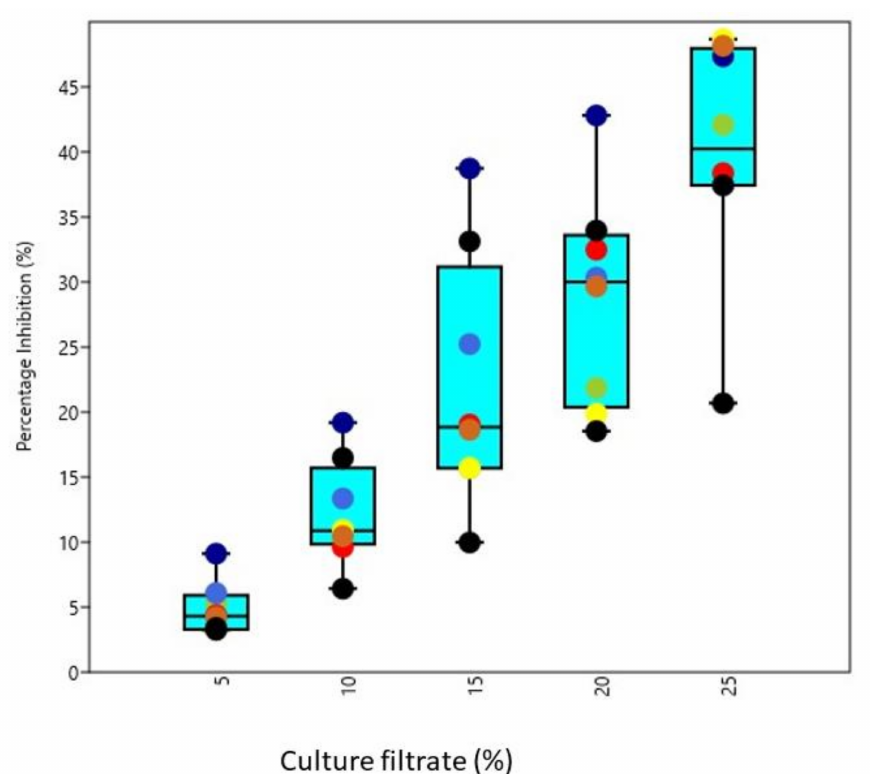
Figure 8. Box and Jitter plot representing percentage inhibition of F. solani by various chitinase producing Trichoderma isolates. [Symbols in the plot represent: AT2: Orange; AT3: Black; AT7: Blue;